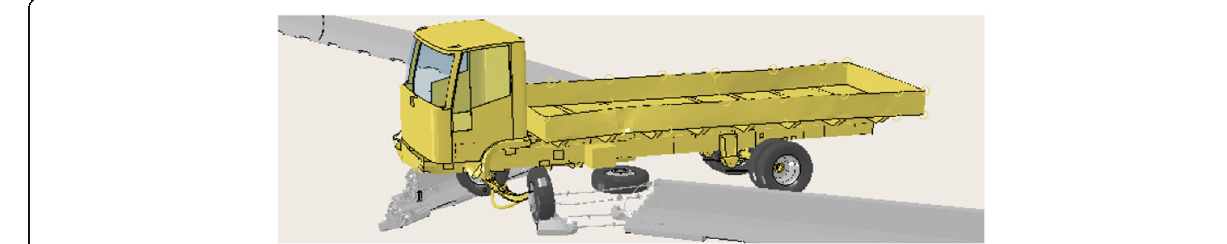
Fig. 11 Example of a numerical test involving a heavy goods vehicle penetrating a